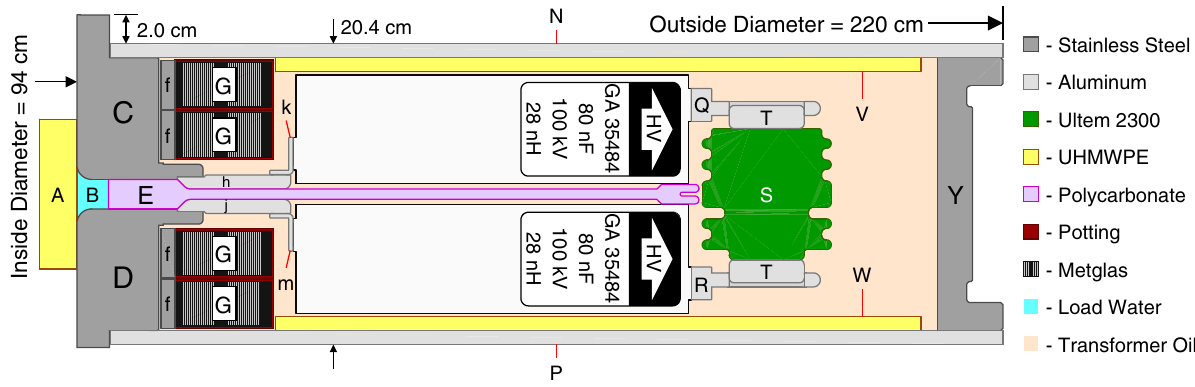
FIG. 2. Cross section (r-z plane) view of the 100-GW “ Z-Next ” LTD. (A) cylindrical load water insulating barrier, (B) cylindrical load water volume, (C) negative output electrode (cylindrical), (D) positive output electrode (cylindrical), (E) cylindrical “ middle insulator ” , (f) cylindrical assembly mandrels for Metglas ribbon cores, (G) cylindrical, potted Metglas magnetic cores, (h) negative capacitor output bus (cylindrical), (j) positive capacitor output bus (cylindrical), (k) negative capacitor mounting bracket, (m) positive capacitor mounting bracket, (N) “ top ” LTD lid (cylindrical), (P) “ bottom ” LTD lid (cylindrical), (Q) positive charge terminal and switch mount, (R) negative charge terminal and switch mount, (S) 200 kV gas switch, (T) switch terminals, (V) “ top ” lid insulator (cylindrical), (W) “ bottom ” lid insulator (cylindrical), (Y) outer cylindrical wall of cavity. Component materials are as specified by the legend at right. The cylindrical axis of the assembly is to the left of the illustration. Charging circuitry, trigger circuitry, switch gas supply, load water supply, diagnostics, seals, and fasteners are omitted from this